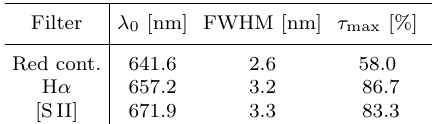
Table 2. Characteristics of the narrow-band